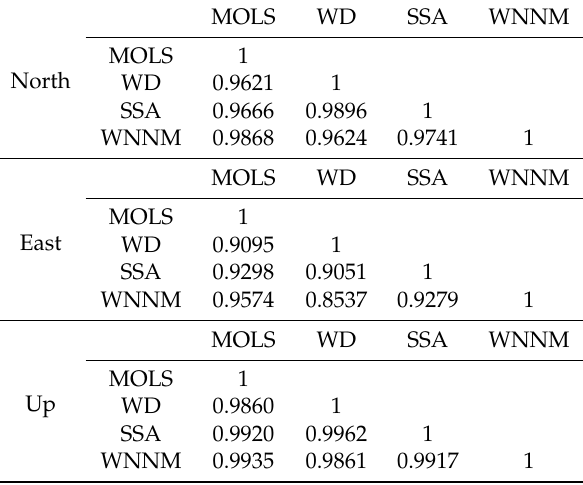
Figure 9. Results of BJFS station. ( a ) North component; ( b ) East component; ( c ) Up component and ( d ) East component, but the trend have been removed by LS. Table 7. Correlation coefficients between the extracting result of WNNM and results from MOLS, WD and SSA for the North, East and Up components of